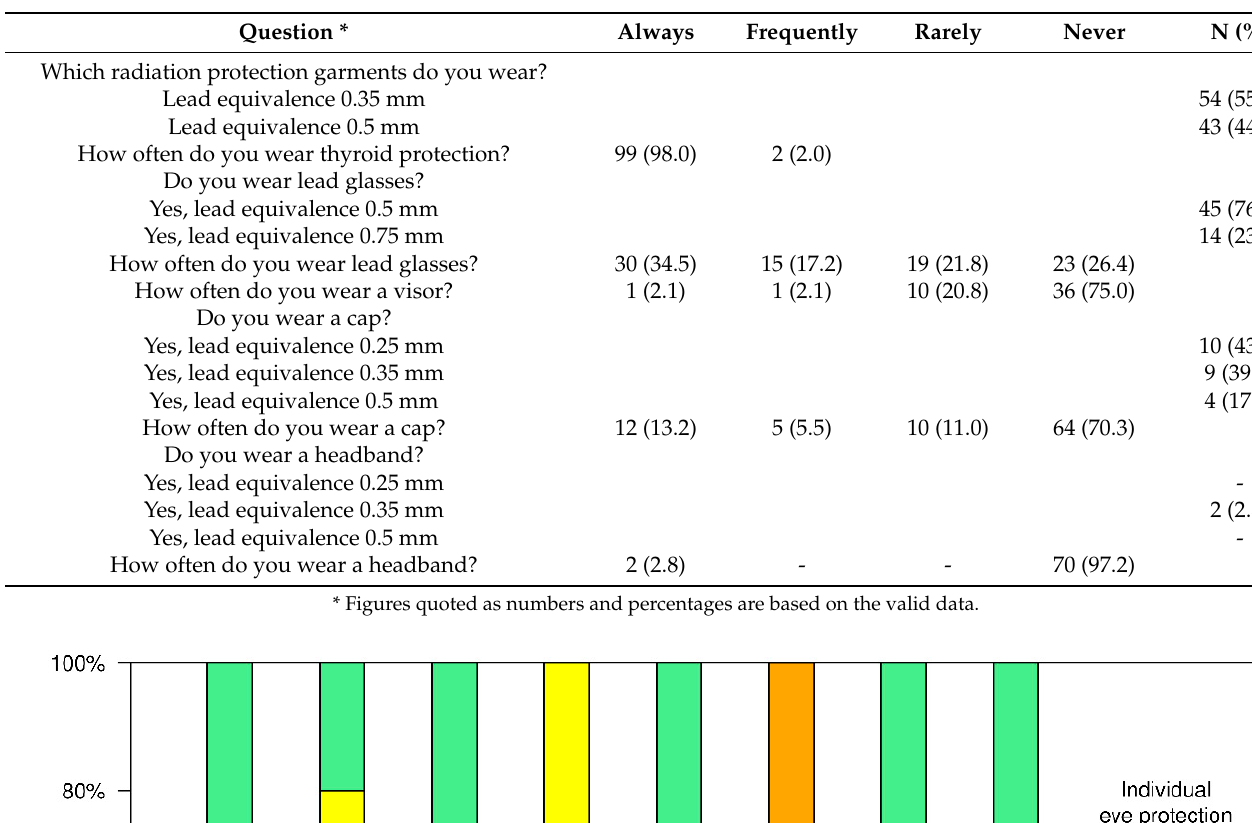
Table 2. Information on personal protective equipment (N = 104).